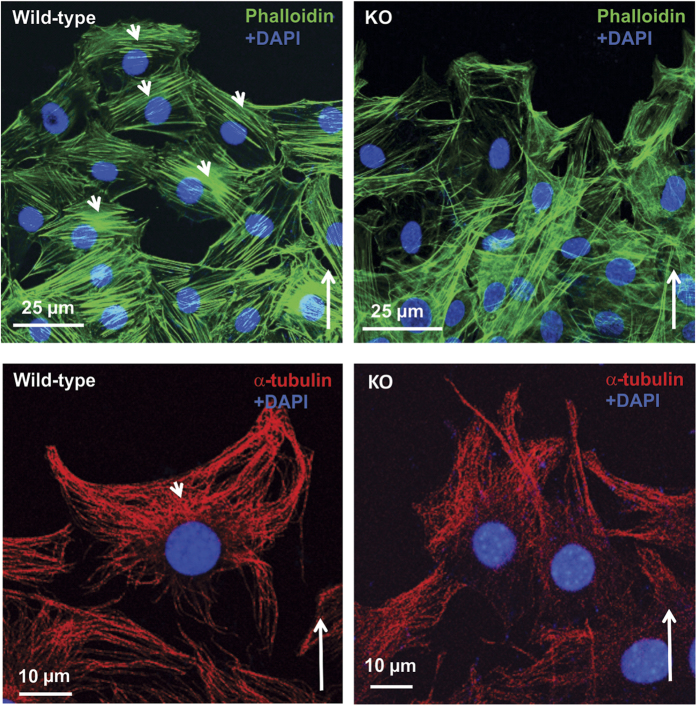
Abnormal distribution of cytoskeleton components in the Spag6-deficient (KO) MEFs during migration.Upper panels: F-actin distribution; Lower panels. α–tubulin distribution. Notice that in the wild-type MEFs (left panels), both F-actin and α–tubulin distribute to the migrating front area (arrow heads), but this pattern is lost in the Spag6-deficient MEFs. The long arrows show migration direction.